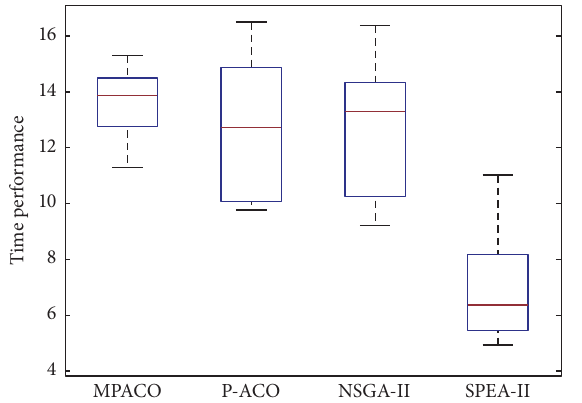
Figure 8: Boxplot of time performance on Scale 1 (in secs).